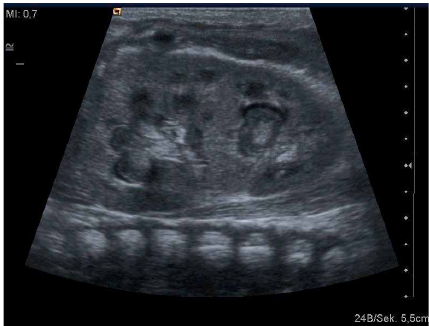
Figure 1: Left kidney with hydronephrosis and fungus balls in the collecting system.